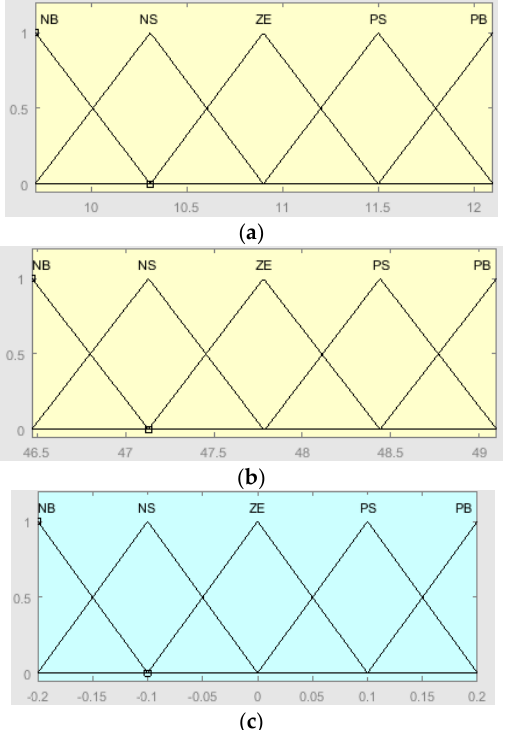
Figure 17. Input ( a , b ) and output ( c ) Membership Functions of F-LC for PEM-FC